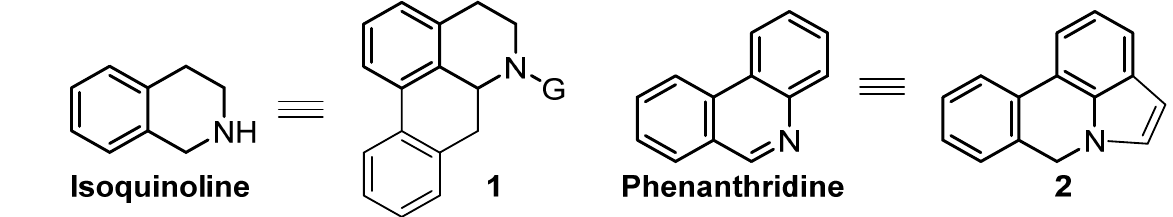
Figure 1. Fused systems based on the isoquinoline and phenanthridine scaffolds.